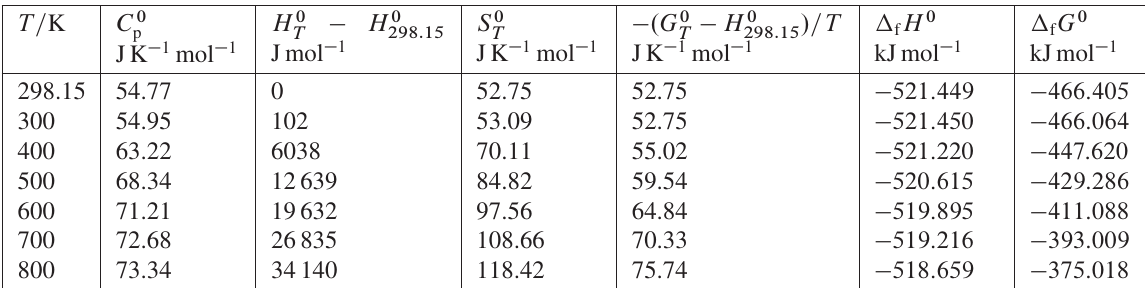
Table 8. Reassessed thermodynamic data for MnO 2